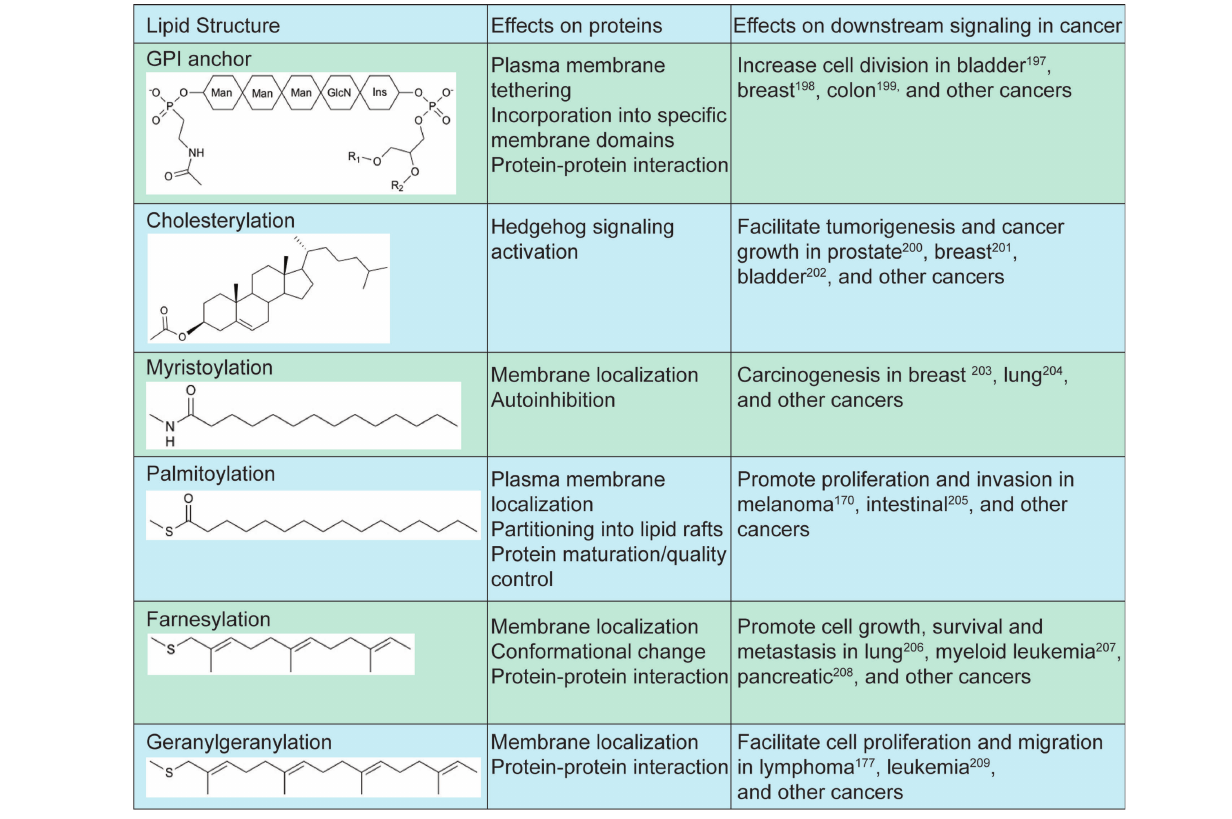
FiGURe 2 | Lipidation structures and effects on downstream signaling in cancer. Increase GPI transamidase activity leads to increased cell proliferation in bladder (174), breast (175), and colon (176) cancers. Elevated hedgehog signaling is linked to sporadic tumorigenesis in prostate (177), breast (178), and bladder (179) cancers. Increased NMT activity and myristoylated Src kinases are linked to increased cell proliferation in breast (180), lung (181), and other cancers. Palmitoylation of signaling proteins in multiple pathways are linked to proliferation and invasion in melanoma (171), intestinal (182), and other cancers. Targeting farnesylation of Ras proteins slows down tumor progression in lung (183), leukemia (184), pancreatic (185), and other cancers. Geranylgeranylation of small GTPases facilitate cell proliferation and migration in lymphoma (186), leukemia (187), and other